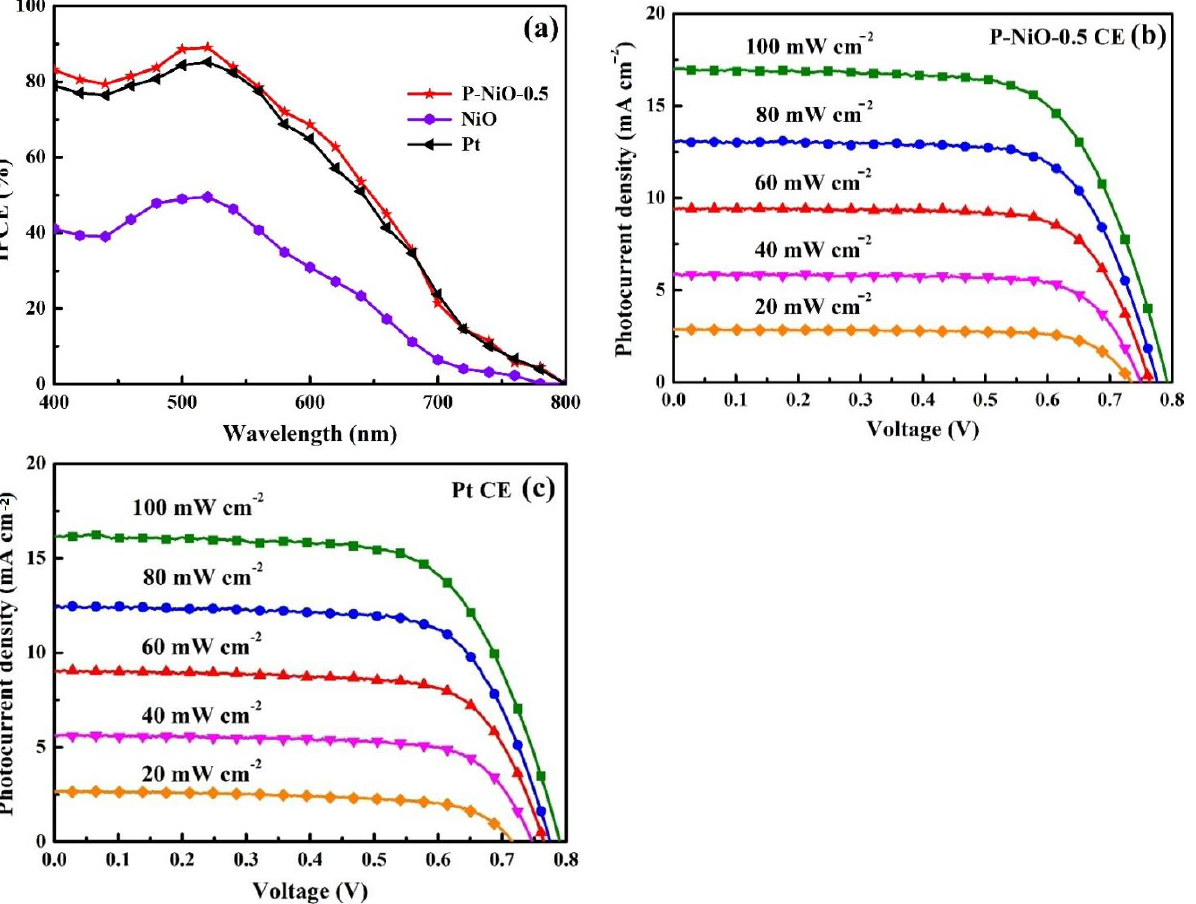
Figure 7. ( a ) IPCE curves of the DSSCs with P-NiO-0.5, NiO and Pt CEs, ( b ) photocurrent density-voltage curves of the DSSCs with the P-NiO-0.5 CE obtained at different light conditions and ( c ) photocurrent density-voltage curves of the DSSCs with the Pt CE obtained at different light conditions.